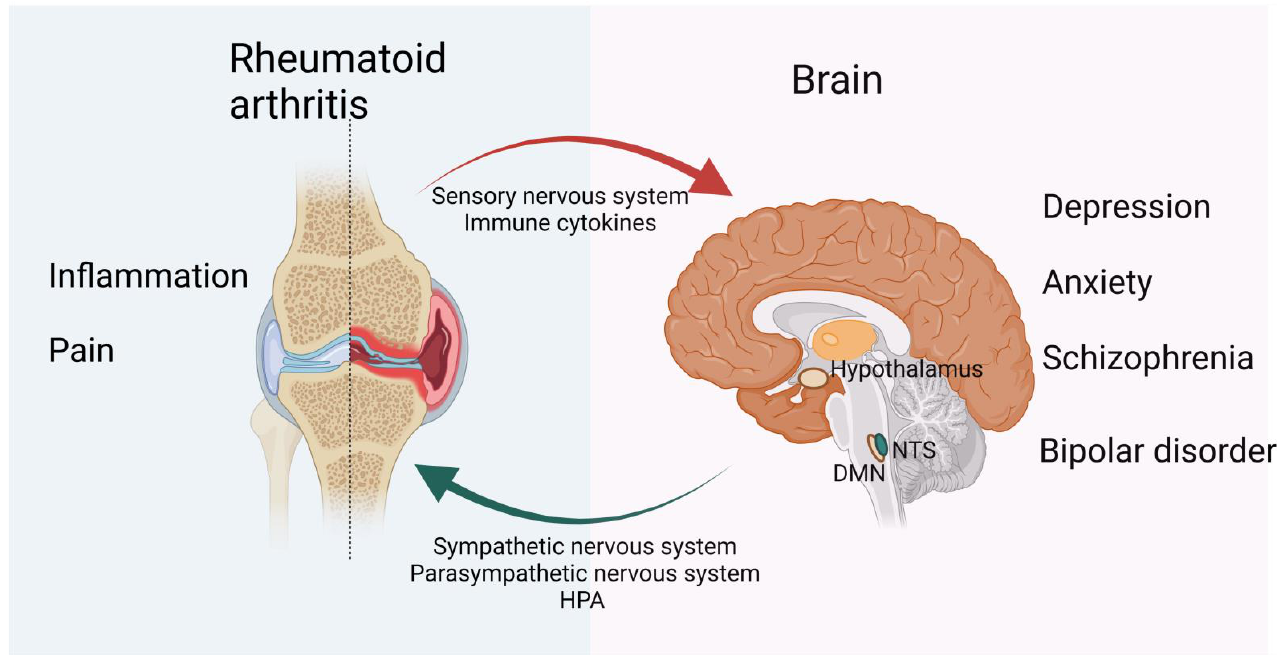
Figure 1. Bidirectional psychological and neurological effects of RA and the brain on each other. Recurrent pain and prolonged inflammation are prominent symptoms of RA and are strongly associated with mental illnesses such as depression and anxiety. In contrast, mental health can influence RA disease activity and is associated with reduced treatment response in RA patients. For example, patients with depression have an increased risk of RA, while antidepressants are reported to have a protective and therefore confounding effect on RA. The CNS and PNS both play a role in inflammation. The vagus nerve is the main efferent pathway that mediates immunosuppression of the CNS. It controls the production of TNF and other proinflammatory cytokines through the splenic nerve. Sensory nerves are activated by proinflammatory cytokines, such as IL-1 and IL-6, and sensory immune information is then sent to regions of the brain and spinal cord to mount an appropriate response. The HPA axis and SNS then carry information from the CNS to the PNS. While the parasympathetic nervous system is anti-inflammatory in the first phase of inflammation, its role in the later phases of chronic inflammation requires further research. Figure created using BioRender (https://biorender.com, accessed on 20 July